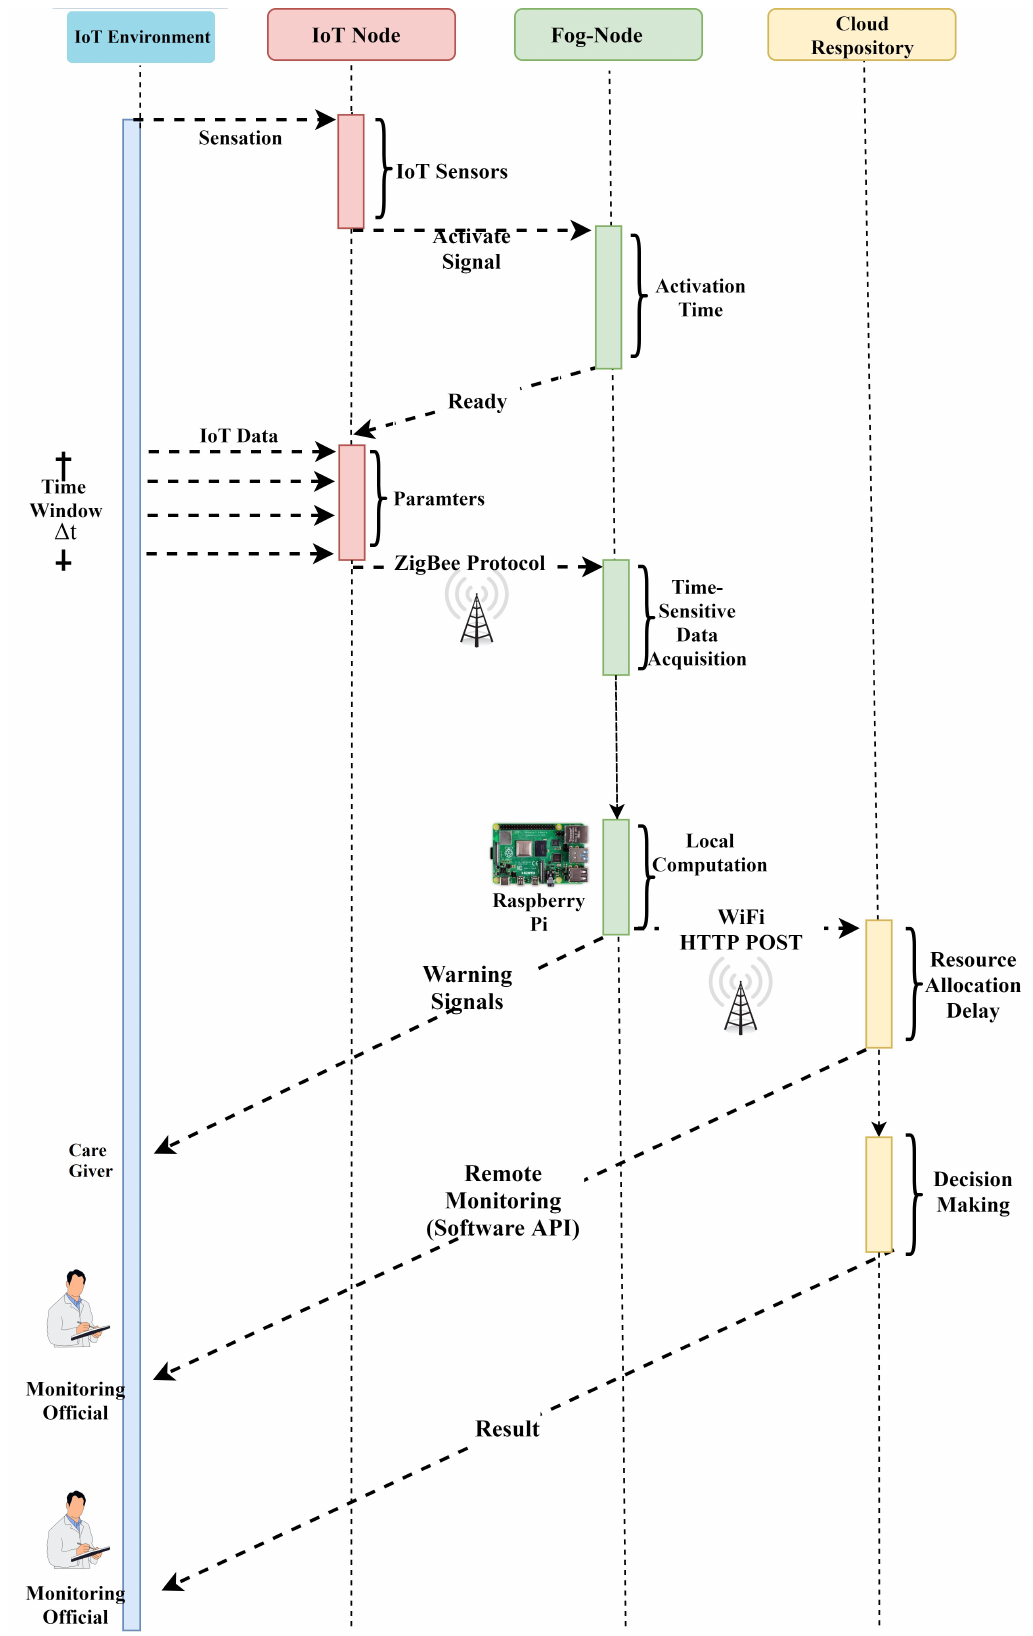
Figure 5. Fog computing-based data